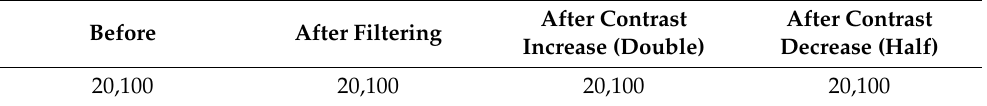
Table 4. Separation of all flame images in the database.